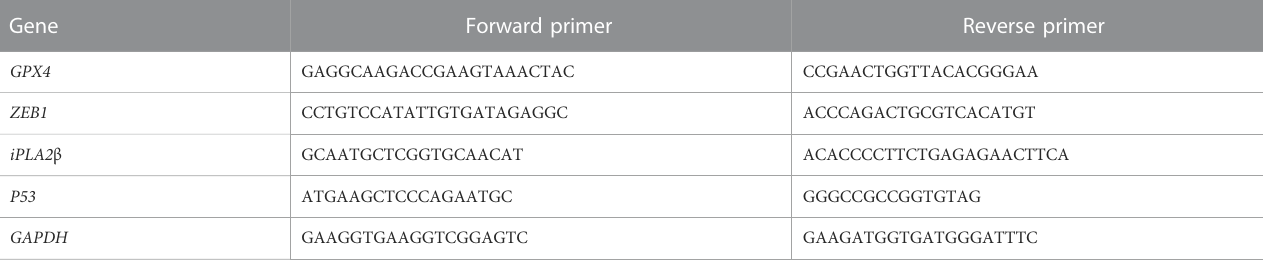
TABLE 1 Sequences of quantitative real-time PCR primers.